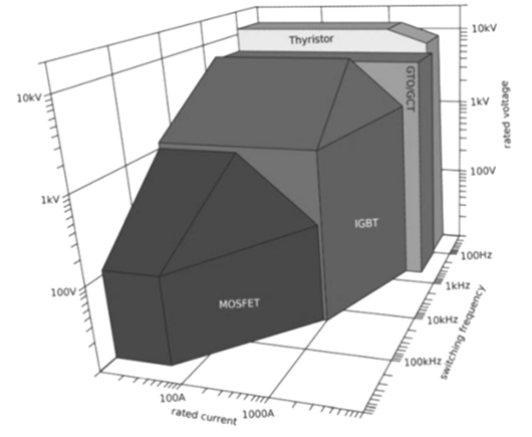
Figure 2. Ratings of selected wide bandgap (WBG) power devices (after[7]).